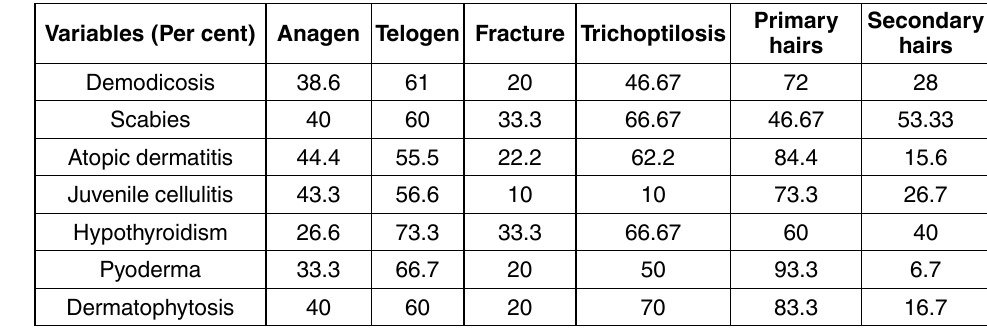
table 3. Trichographic findings of hairs of dogs with mucocutaneous lesions Variables (Per cent) anagen telogen Fracture